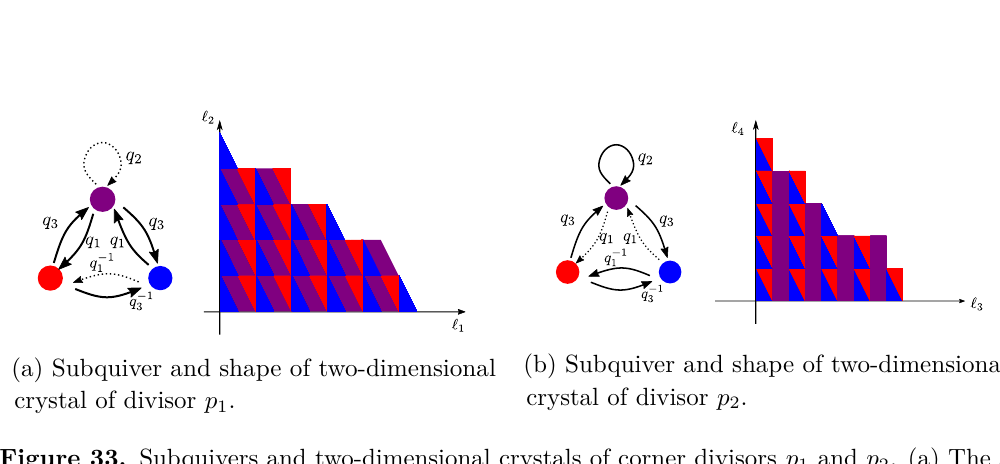
. (b) The arrows removed are m 2